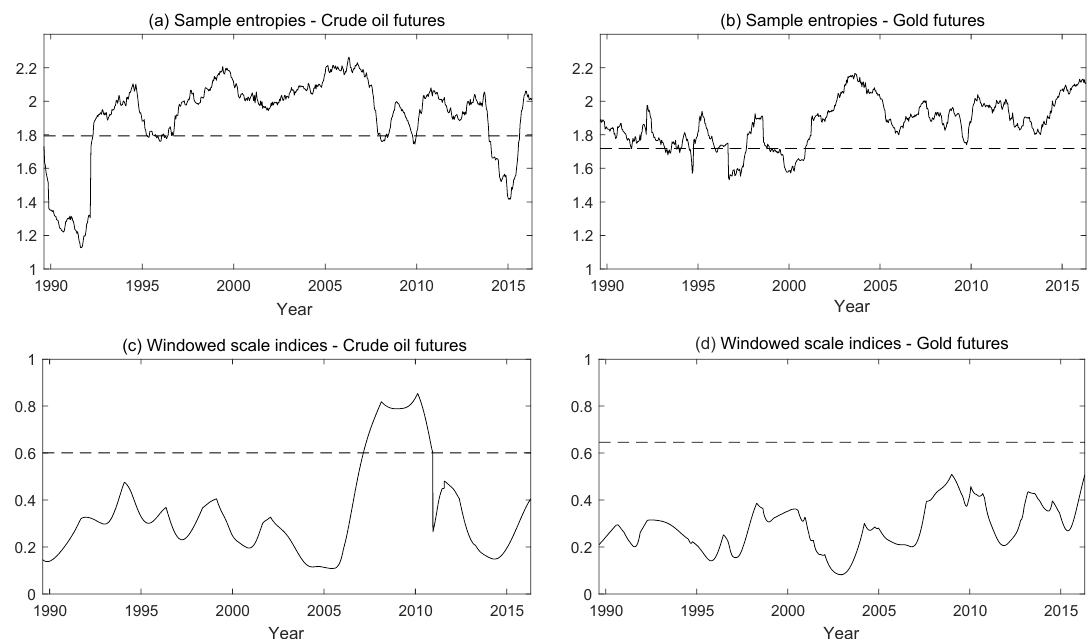
Figure 10. Sample entropies and windowed scale indices of crude oil and gold futures contracts price returns. For the sample entropies (see ( a , b )), we have considered subseries centered at different times with time radius τ = 300 days. With respect to the windowed scale indices (see ( c , d )), they are centered at different times with time radius τ = 300 days, taking s 0 = 8 days and s 1 = 256 days. The corresponding global SampEn and scale index are represented with dashed